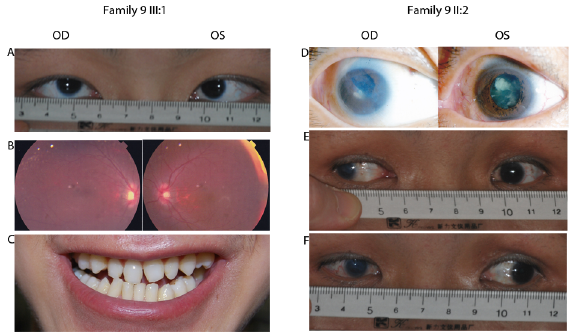
Figure 3. The clinical examination details of patients from the family 9. A–C showed that the member III:1 had bilateral10 mm of the horizontal corneal diameter (A), bilateral mild tigroid retinal change in the temporal region of the optic disc (B), and dental condition without obvious screwdriver incisors or mesiodens (C). D–F showed that the member II:2 had posterior capsule opacification in her left eye and postoperative pupil shift in her right eye (D), 10 mm of the horizontal corneal diameter in her left eye (E), and 8 mm in her right eye